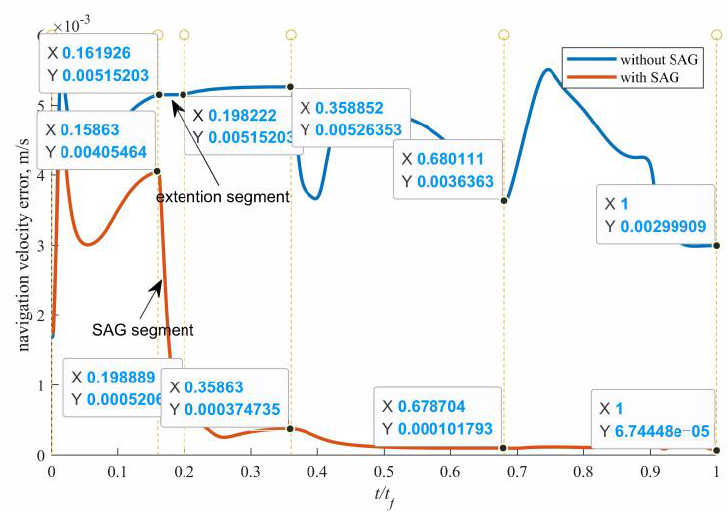
Figure 12. AON velocity error with and without SaG.